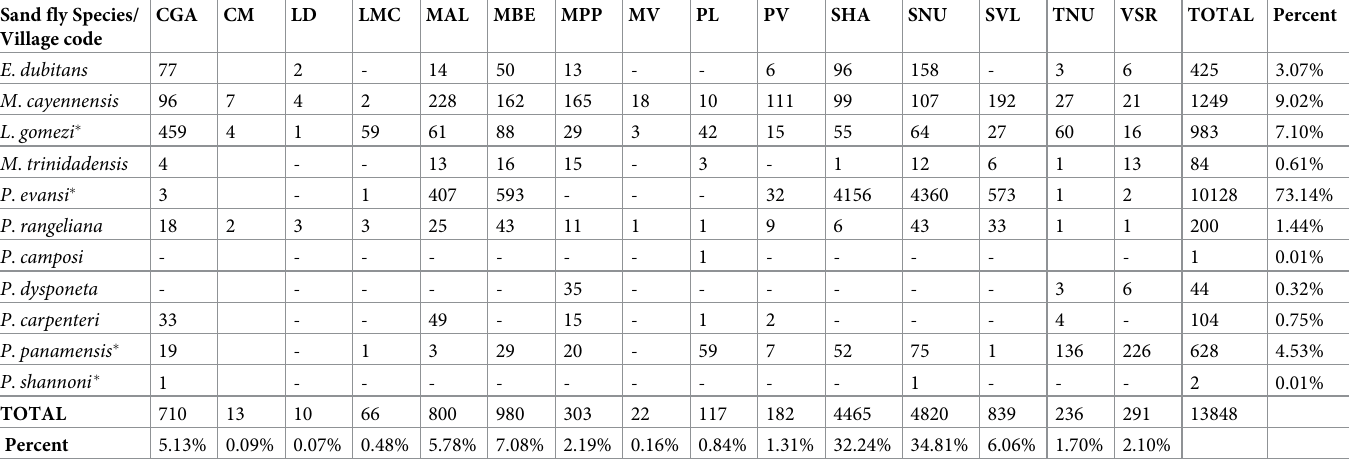
Table 1. Total number of collected sand flies by species in each of 15 localities in the Cordoba department in Colombia. Numbers correspond to number of captured individuals for both intra and peridomicilairy traps of 24 houses in each village. Village code: CGA: Los Cordobas-Guaimaro Abajo, TNU: Tierra Alta-Nueva Union; Saha- gun-Villa Lucia; LMC: Lorica- Mata de Caña, MPP: Montelibano- Pica Pica Nuevo, MV: Monteria-El Vidrial, PLSJ: Puerto Libertador-San Juan, LD:Lorica-La Doctrina; MAL: Moñitos-Altomirar. Sand fly Species/ Village code